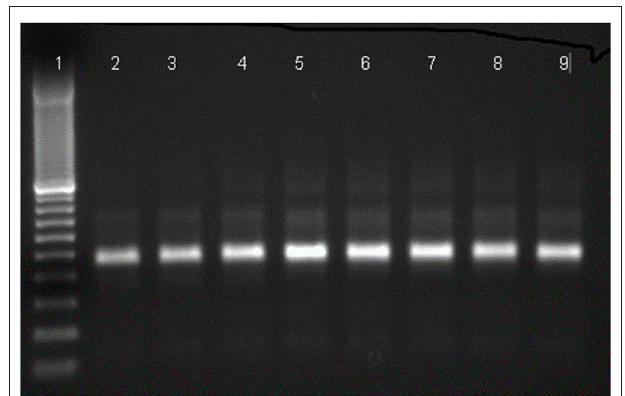
FIGURE 2 | Agarose gel electrophoresis for the detection of amplified dengue virus RNA in Ae aegypti samples by RT-PCR using D1 and D2 primers. Lane (1) 100 bp DNA marker, lane (2-4) positive mosquito samples, lane (5-7) positive control, lane (8, 9) positive mosquito samples.